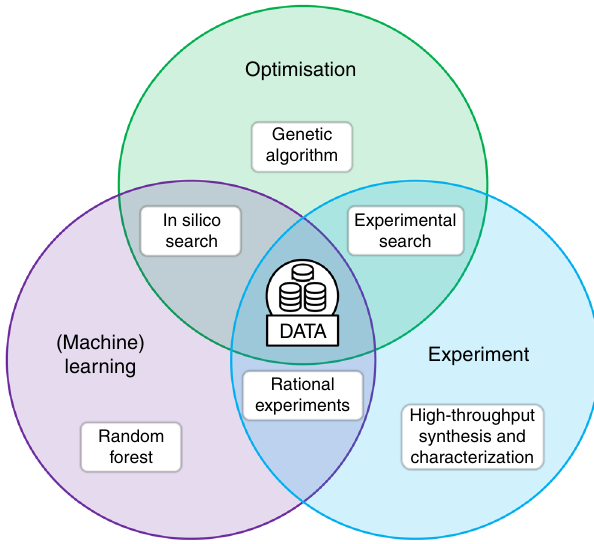
Fig. 5 Schematic of the components of the framework used for